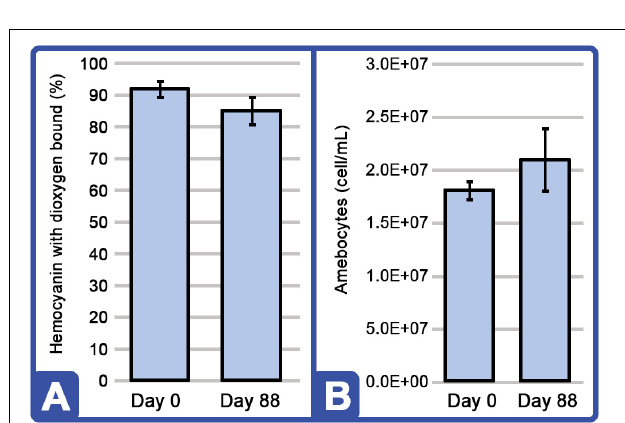
FIGURE 5 | HSC dioxygen-bound hemocyanin (Oxy-Hc) and amebocyte density stability throughout the 88 days study. (A) Percentage of Oxy-Hc from aquaculture HSC hemolymph RAS. (B) Aquaculture HSC amebocyte density concentration. Results are represented as mean ± SD between individual HSCs in Cohort A ( n =